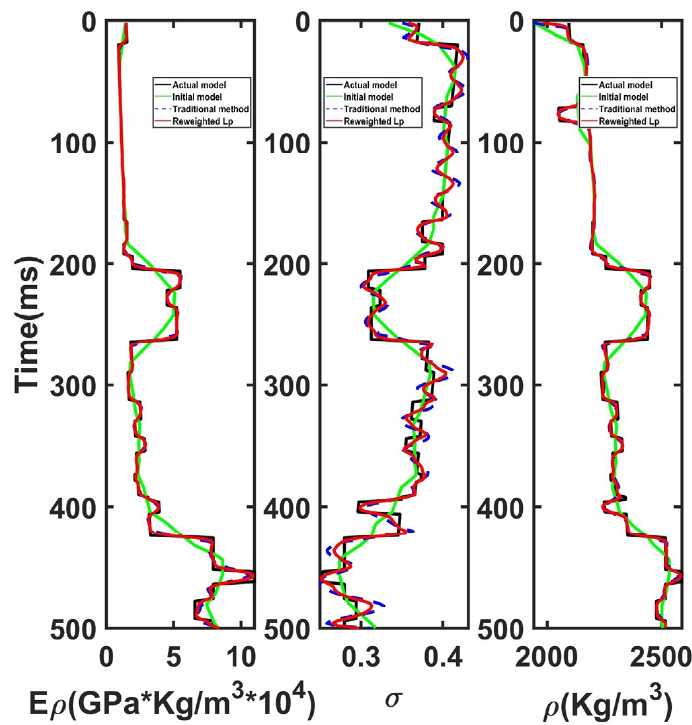
Figure 22. Comparison of inversion results for the 500th trace after adding noise.